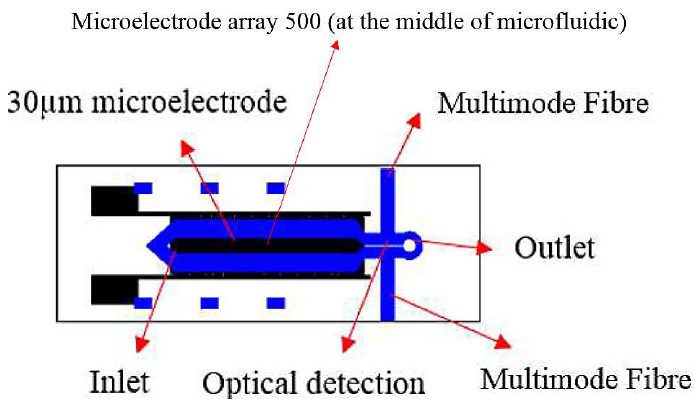
Figure 2. A schematic diagram of the integrated Lab on Chip